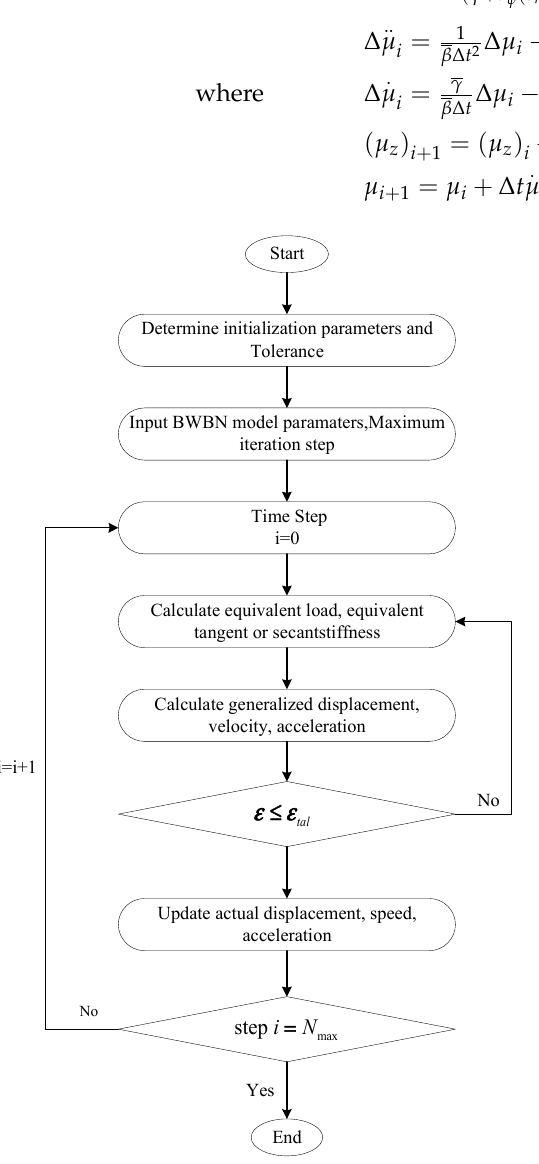
Figure 2. The flow chart of Newmark- β [62].